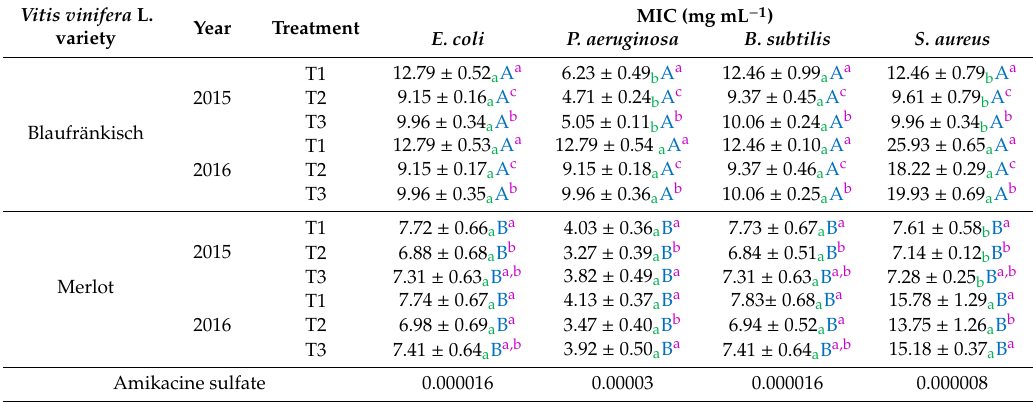
Di ff erent green subscript lower case letters in each row indicate statistically significant di ff erences ( p < 0.001) between years for the same variety and same treatment. Di ff erent blue upper case letters in each row indicate statistically significant di ff erences ( p < 0.001) between varieties for the same year and same treatment. Di ff erent magenta superscript lower case letters in each row indicate statistically significant di ff erences ( p < 0.001)